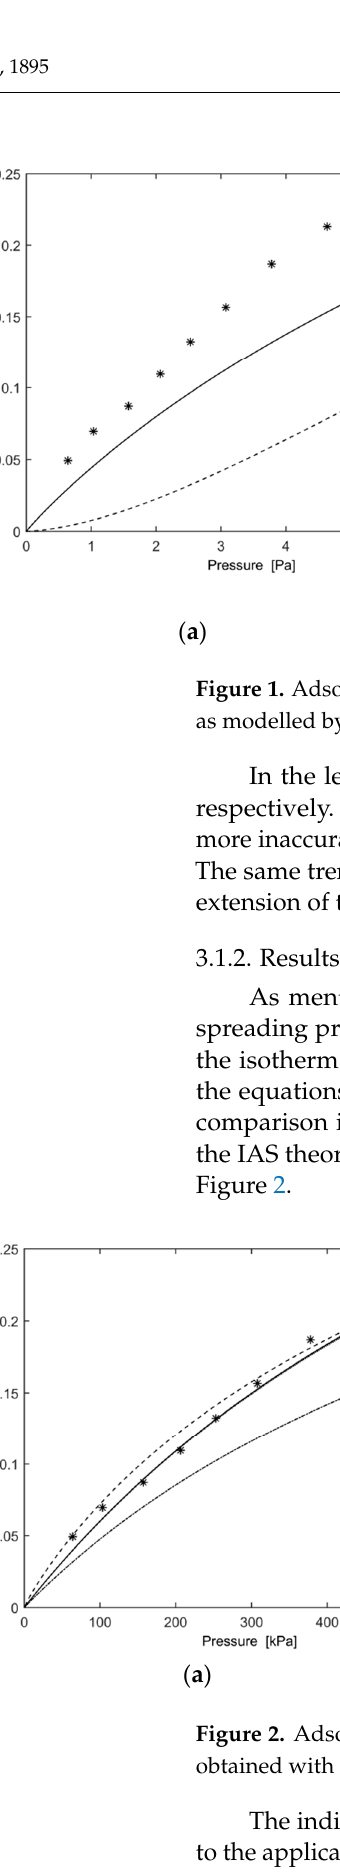
( b ) Figure 3. Adsorption results for ( a ) nitrogen and ( b ) methane, as experimentally observed and as obtained with the two implemented models of the Fast-IAS theory.